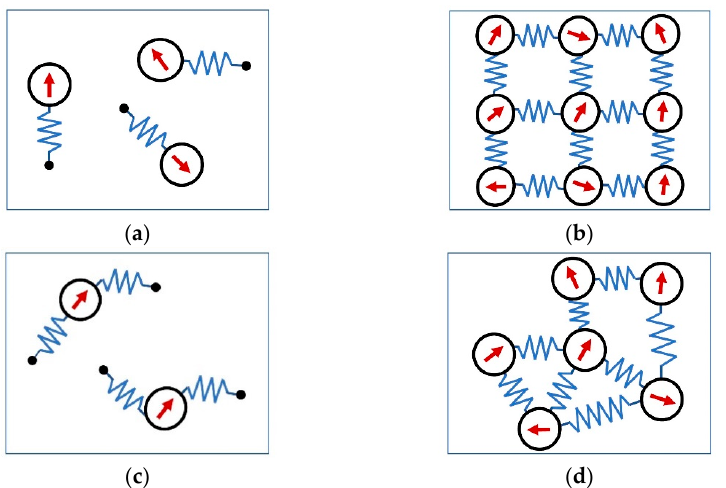
Figure 3. Elastic springs connecting magnetic particles to one ( a ) or two ( b ) anchoring points; elastic springs connecting centers of magnetic particles forming a regular ( c ) or irregular ( d ) network. Red arrows denote magnetic moments of particles.